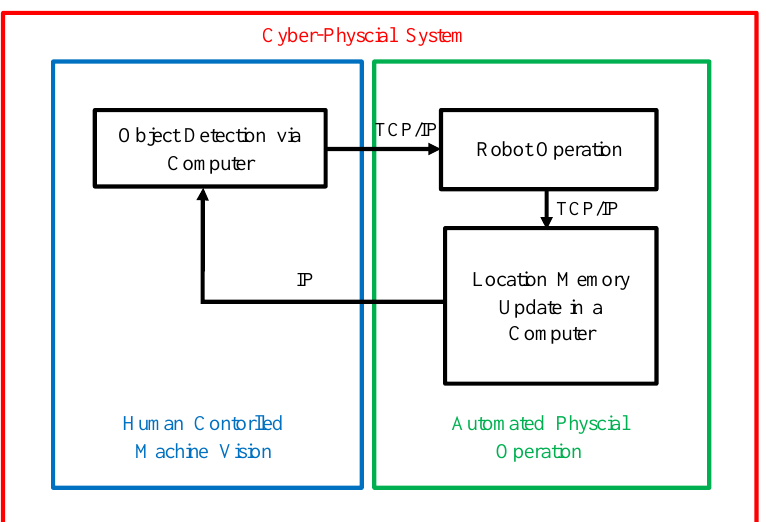
Figure 5. Conceptual cyber-physical system that uses machine vision and a robotic system. Data exchange protocols between various components are also shown. Figure 6. Actuation system capable of implementing control actions. Framework involves laptop computer (computing system), cable for socket communication (follows TCP/IP standards), and UR5 robot.